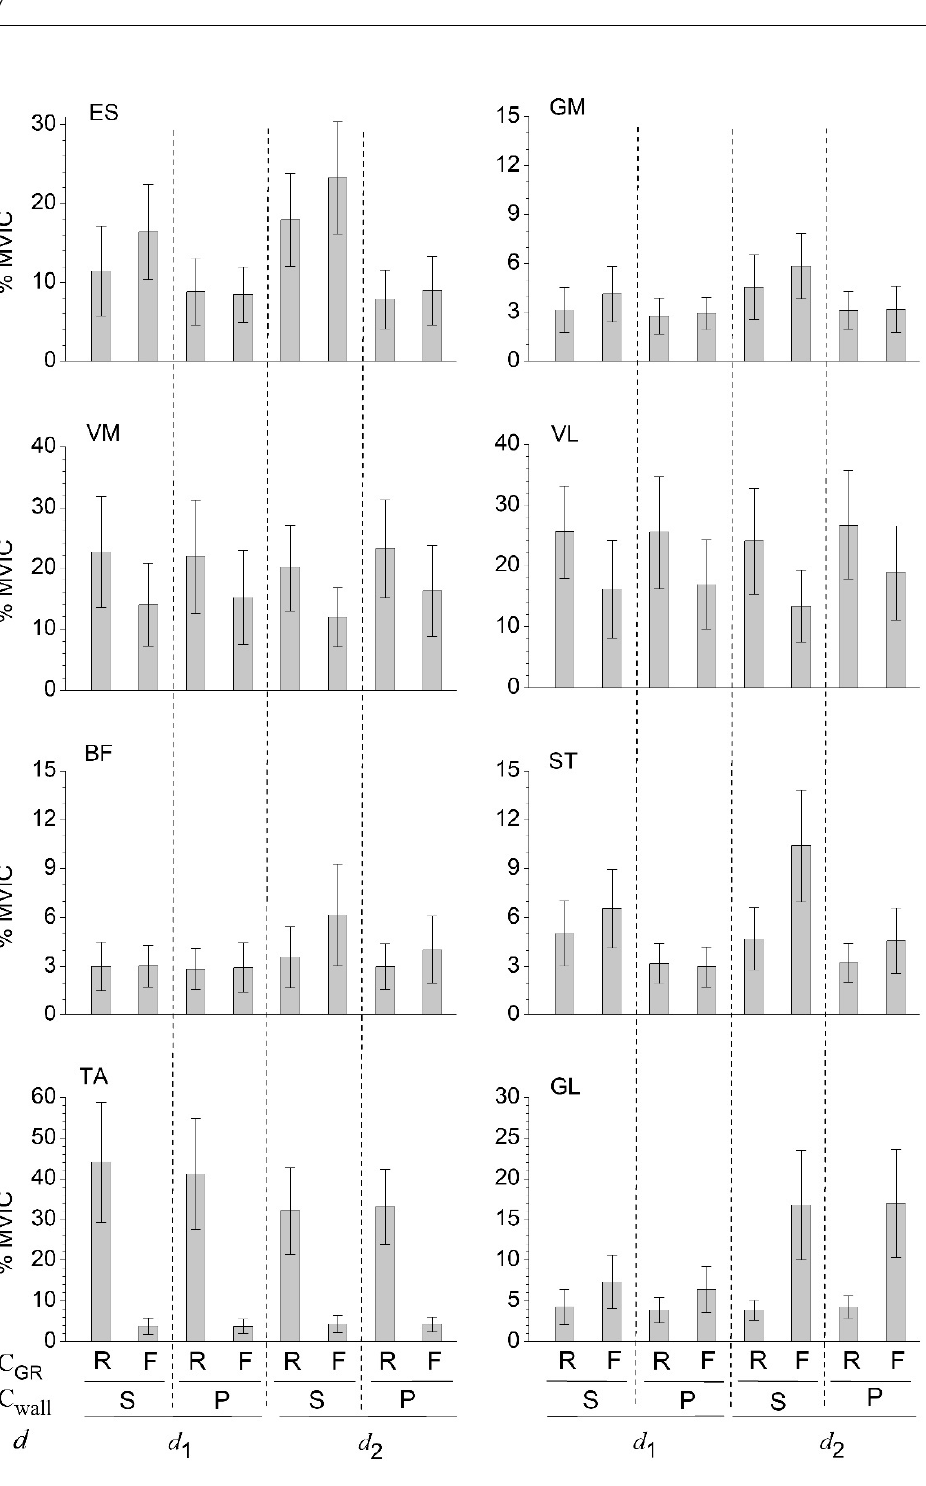
Figure 2. Mean muscle activation levels (expressed as a percentage of the peak electromyographic amplitude at MVIC) recorded during the SBWS exercise executed with knees flexed at 45 ◦ and in two different conditions for each of the three exercise variables: (1) horizontal distance d of the ankles from the wall ( d 1 = 0.5 · l thigh and d 2 = l thigh ); (2) scapular (S) or pelvic (P) location of C wall ; (3) rearfoot (R) or forefoot (F) location of C GR . ES = erector spinae, GM = gluteus maximus, VM = vastus medialis, VL = vastus lateralis, BF = biceps femoris, ST = semitendinosus, GL = gastrocnemius lateralis, TA = tibialis anterior; S: C wall at the scapular zone, P: C wall at the pelvic zone, R: C GR at rearfoot, F: C GR at forefoot.